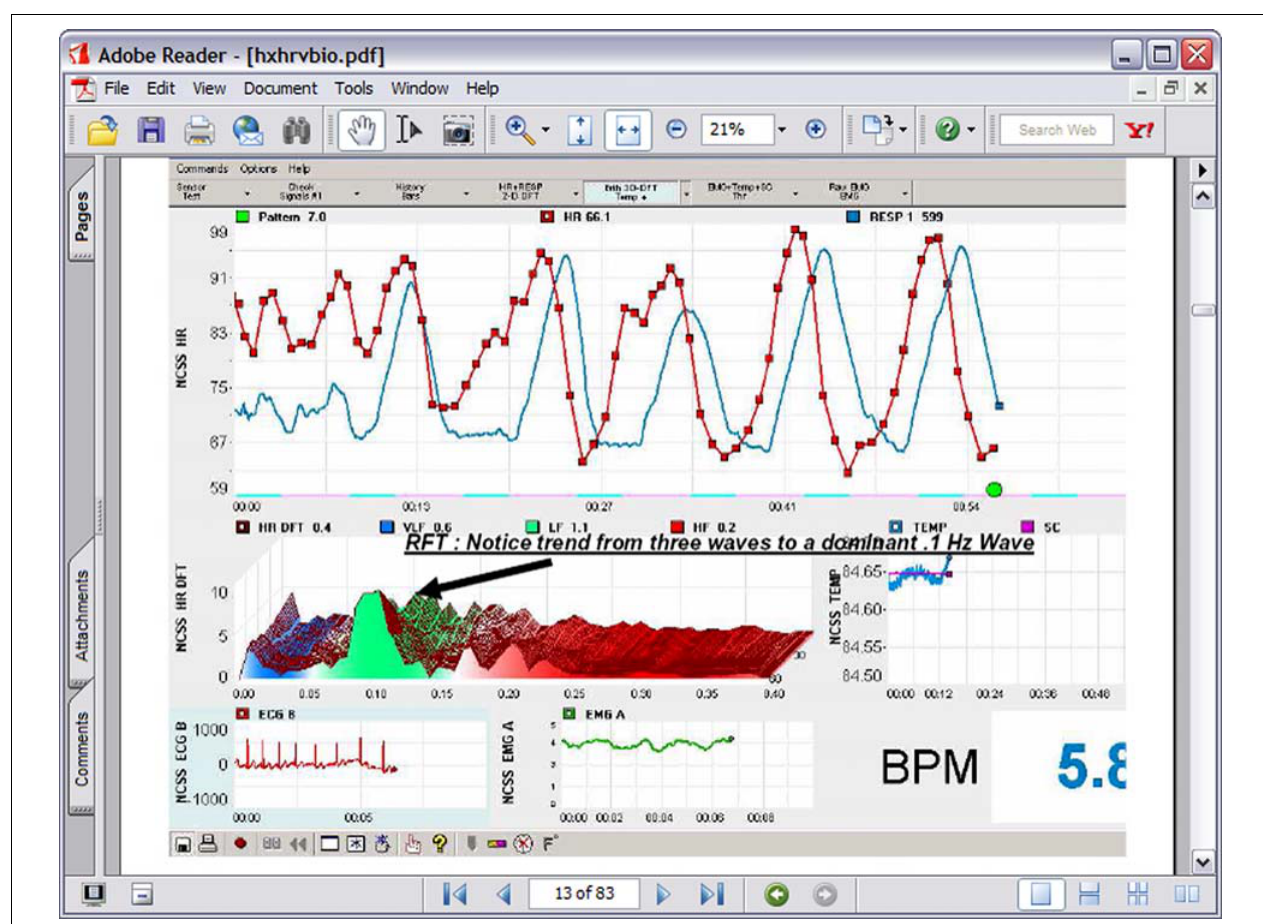
FIGURE 1 |A typical HRVB screen showing the transition from normal breathing to 7 breaths per minute breathing.